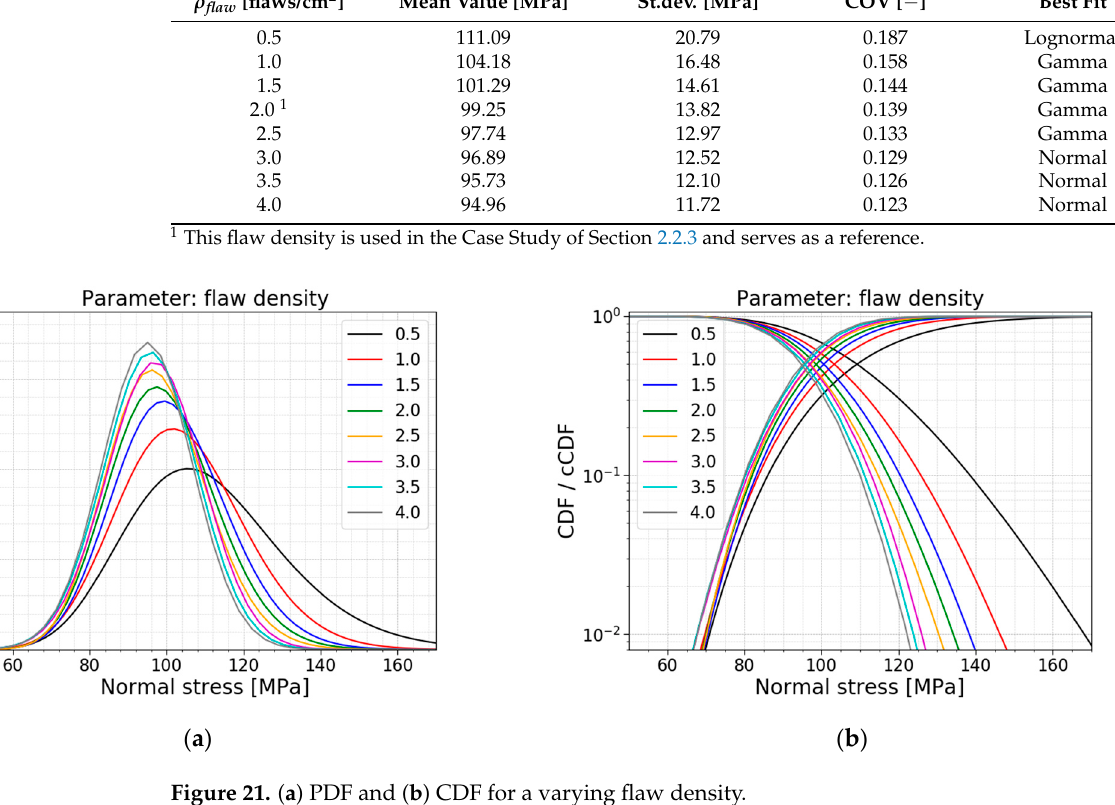
( b ) Figure 22. ( a ) AIC values and ( b ) the mean and st.dev. of the normal stress at failure for a varying flaw density. Table 7 and Figure 22b prove that a larger flaw density causes a smaller mean value, standard deviation and COV for the normal stress distribution. A larger flaw density re- sulted in more flaws on the glass surface and subjected to the tensile stresses resulting from the bending moments. This ensures that there is a larger probability for a deep flaw to be present, which causes the glass to fail at a lower fracture load, which goes hand in hand with lower normal stresses at the moment of failure. Figure 21 visualizes the smaller values and a more narrow distribution for larger flaw densities. Another observation is again a switch in the best distribution fit. The data for a setup with a flaw density equal to 0.5 flaws/cm 2 has the best fit with a lognormal distribution. For flaw densities ranging from 1.0 to 2.5 flaw/cm 2 , the best fit changes to a gamma distri- bution. Furthermore, flaw densities higher than and equal to 3.0 flaws/cm 2 have a best fit with a normal distribution. The AIC values in Figure 22a also illustrate the Gumbel fit worsening when considering larger flaw densities.